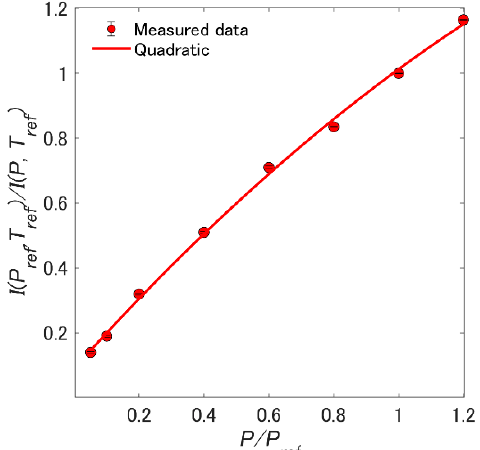
Figure 7. Pressure calibration with the reference pressure P ref = 100 kPa and temperature T ref = 303 K.